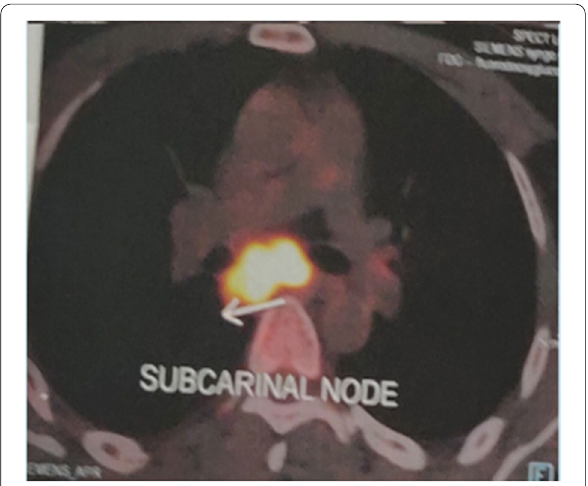
Fig. 3 PET CT showing FDG avid mediastinal nodes—subcarinal